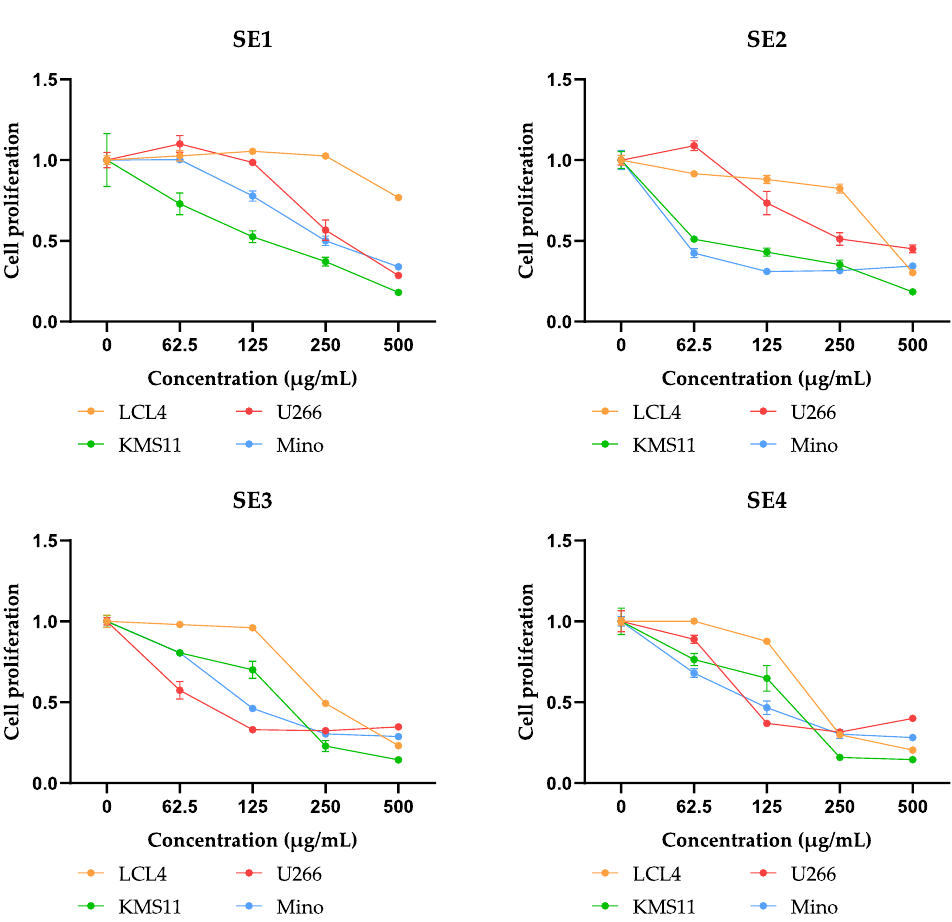
Figure 2. Dose – response curves of obtained fractions (SE1-SE4) from the ethyl acetate (SE) extract of C. speciosa for cytotoxic activities against LCL, U266, KMS11, and Mino cell lines. C. speciosa for cytotoxic activities against LCL, U266, KMS11, and Mino cell